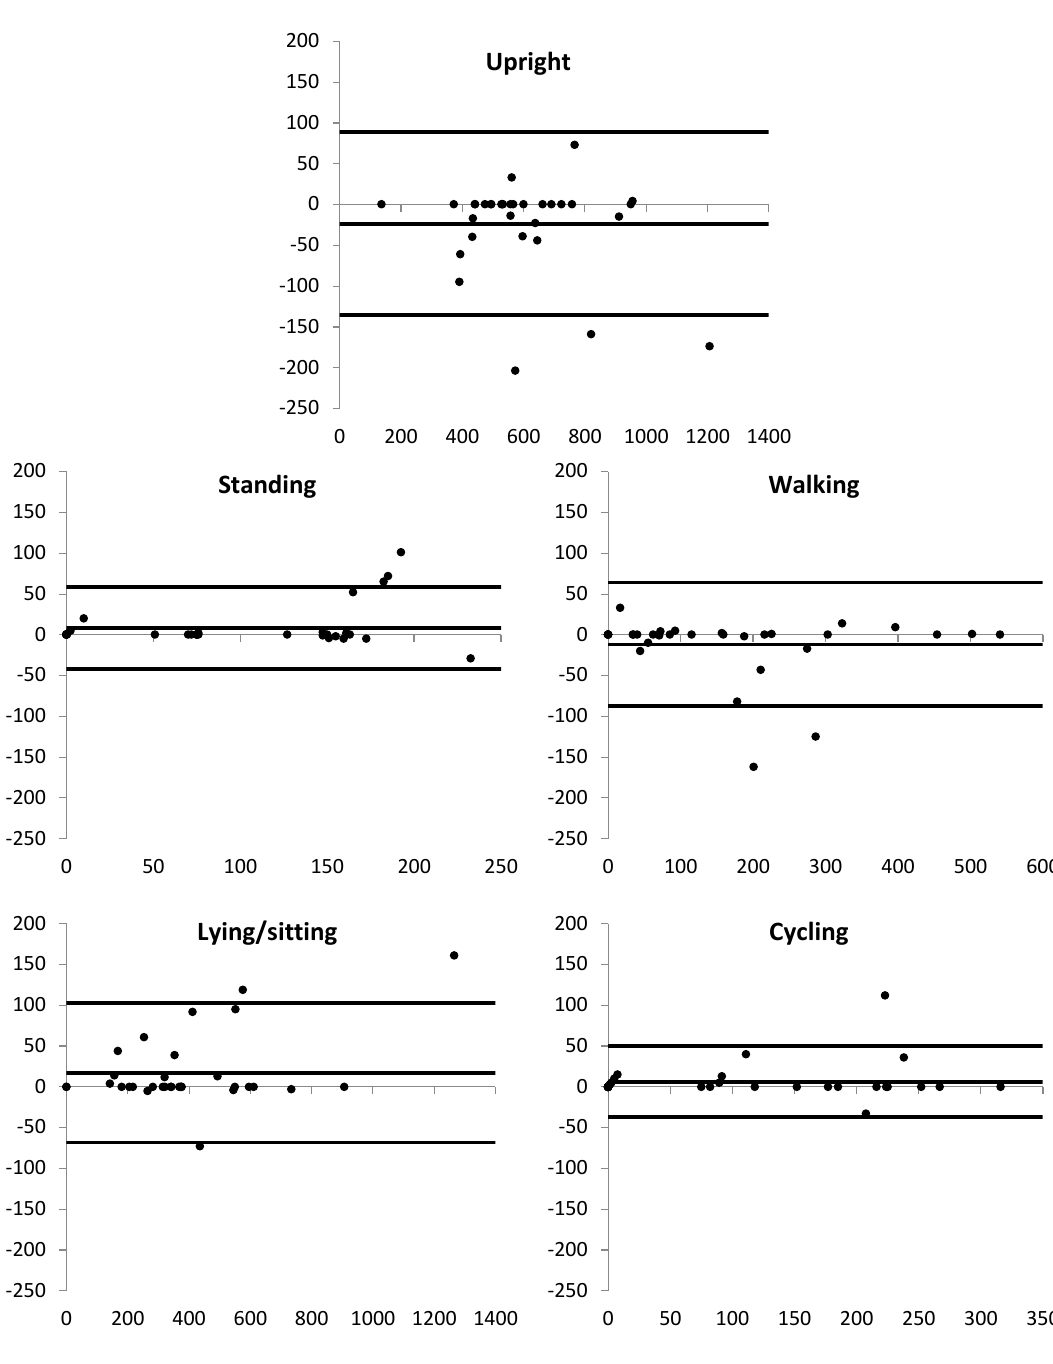
Figure 2. The Bland–Altman plots (x-axis: mean of Activ8 and video recording; y-axis: difference, calculated as Activ8 minus video recording) of the body postures and movements for all data together. The solid lines are the mean difference and the upper and lower limits of agreement. For “standing” and “walking/running”, only data from the basic activities (performed in the laboratory or at home) were used. Each dot is one assessment.